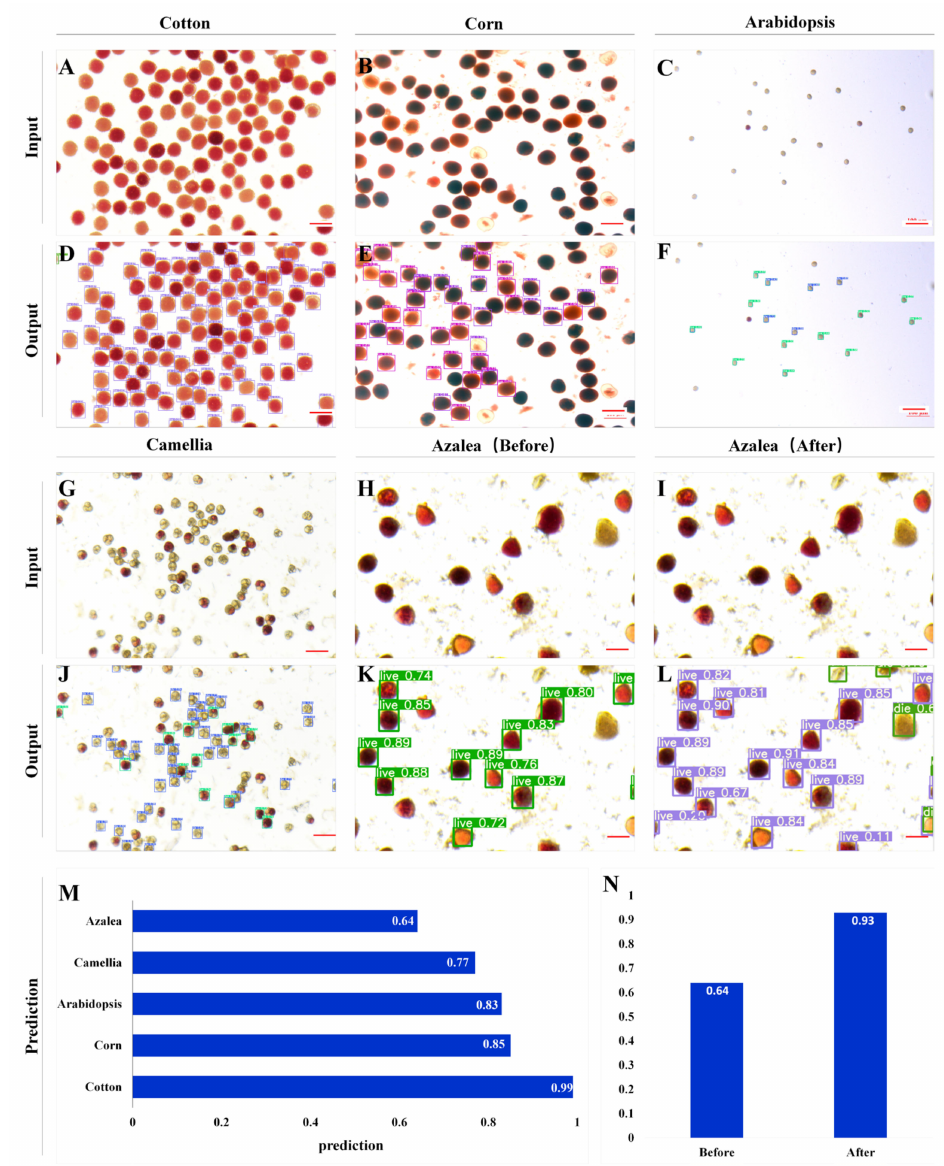
Figure 3. Direct extension of the trained model to the pollen of other plants. ( A – C , G – I ) The input image of pollen stained with TTC solution for cotton ( A ), corn ( B ), Arabidopsis ( C ), camellia ( G ), azalea (( H ) before fine-tuning), and azalea (( I ) after fine-tuning). ( D – F , J , K ) The training algorithm was used to visualize the results of pollen staining image detection for cotton ( D ), corn ( E ), Arabidopsis ( F ), camellia ( J ), and azalea (( K ), before fine-tuning). ( L ) The training algorithm after fine-tuning was used to visualize the results of azalea pollen staining image detection. ( M ) The results of model detection were compared with those of manual labeling, and the average accuracy of model detection was calculated. ( N ) Before and after fine-tuning, the detection results for azalea were compared with those of manual labeling, and the average accuracy of model detection was calculated. ( A – L ) Bars: 100 µ